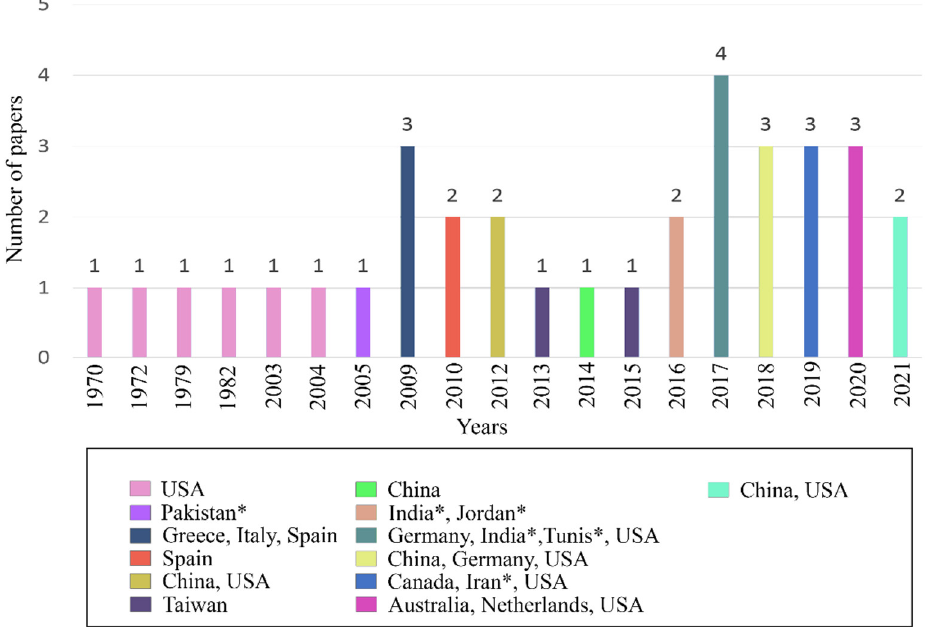
Figure 2. Annual publications of methods for estimating groundwater pumping. * Undeveloped countries.